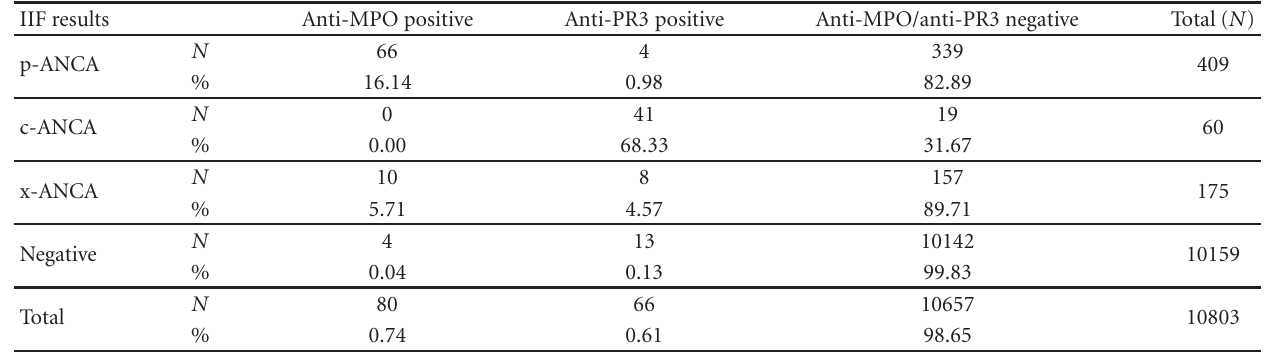
Table 2: Relationship between IIF pattern and ELISA test